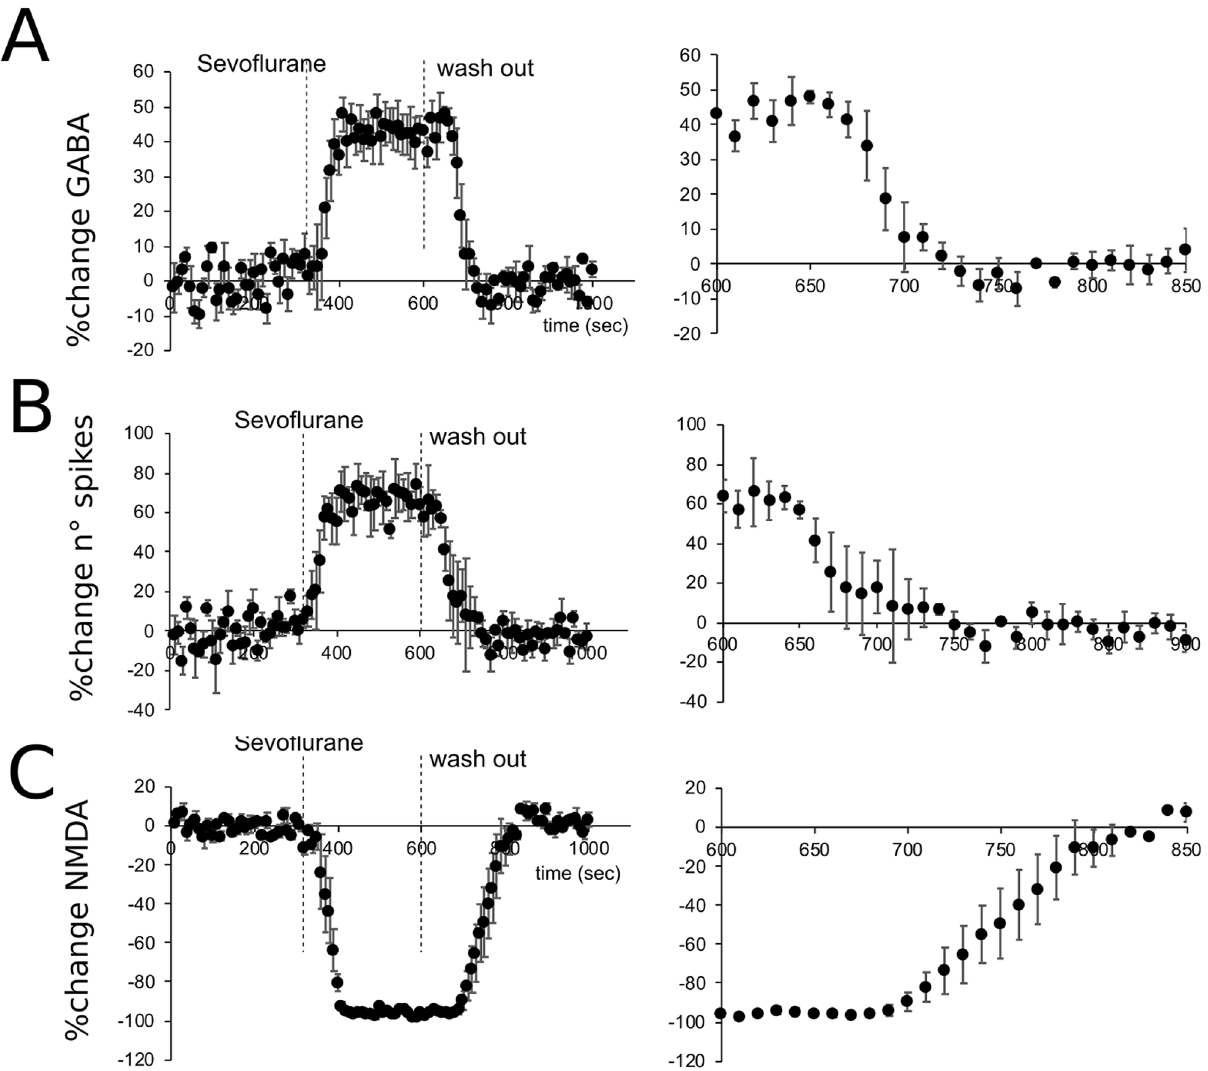
Figure 6. Time courses of the effect of sevoflurane. ( A ) Left; Time courses of the effect of sevoflurane (1st vertical dashed line 300 s) and subsequent wash out (2nd dashed line 600 s) on eIPSCs peak amplitude changes. Right. Inset of the panel shown on the left. Note that the return to the initial level starts 50 s after the beginning of washout and the steady state is obtained in about 100 s. ( B ) Left Time courses of the effect of sevoflurane on the number of spikes evoked in response to a 500 ms 5 pA depolarizing step current. Right. Inset of the panel shown on the left. Note that the return to the initial level starts about 40 s after the beginning of washout and the steady state is obtained in about 100 s. ( C ) Left Time courses of the effect of sevoflurane on the NMDA peak current changes. Right. Inset of the panel shown on the left. Note that the return to the initial level starts about 100 s after the beginning of washout and the steady state is obtained in about 200